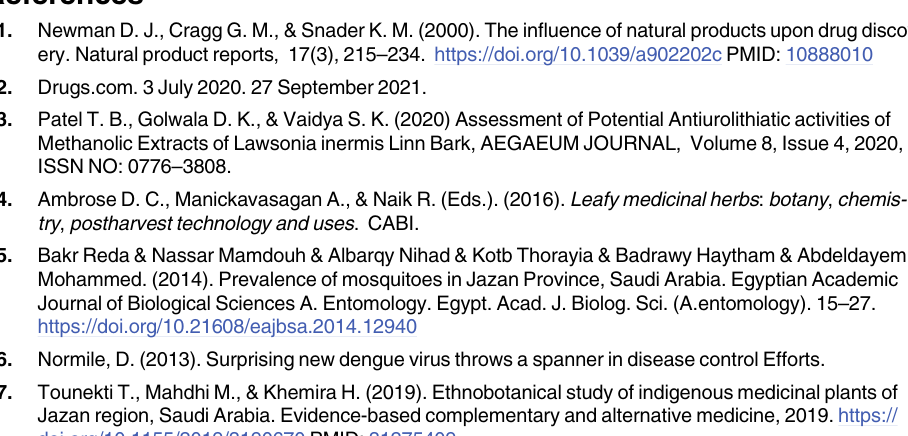
S1 Table. The phytochemical composition of basil by GC-MS. S2 Table. The phytochemical composition of cumin by GC-MS. S3 Table. The phytochemical composition of clove by GC-MS. S4 Table. The phytochemical composition of henna by GC-MS. S5 Table. The phytochemical composition of zingber by